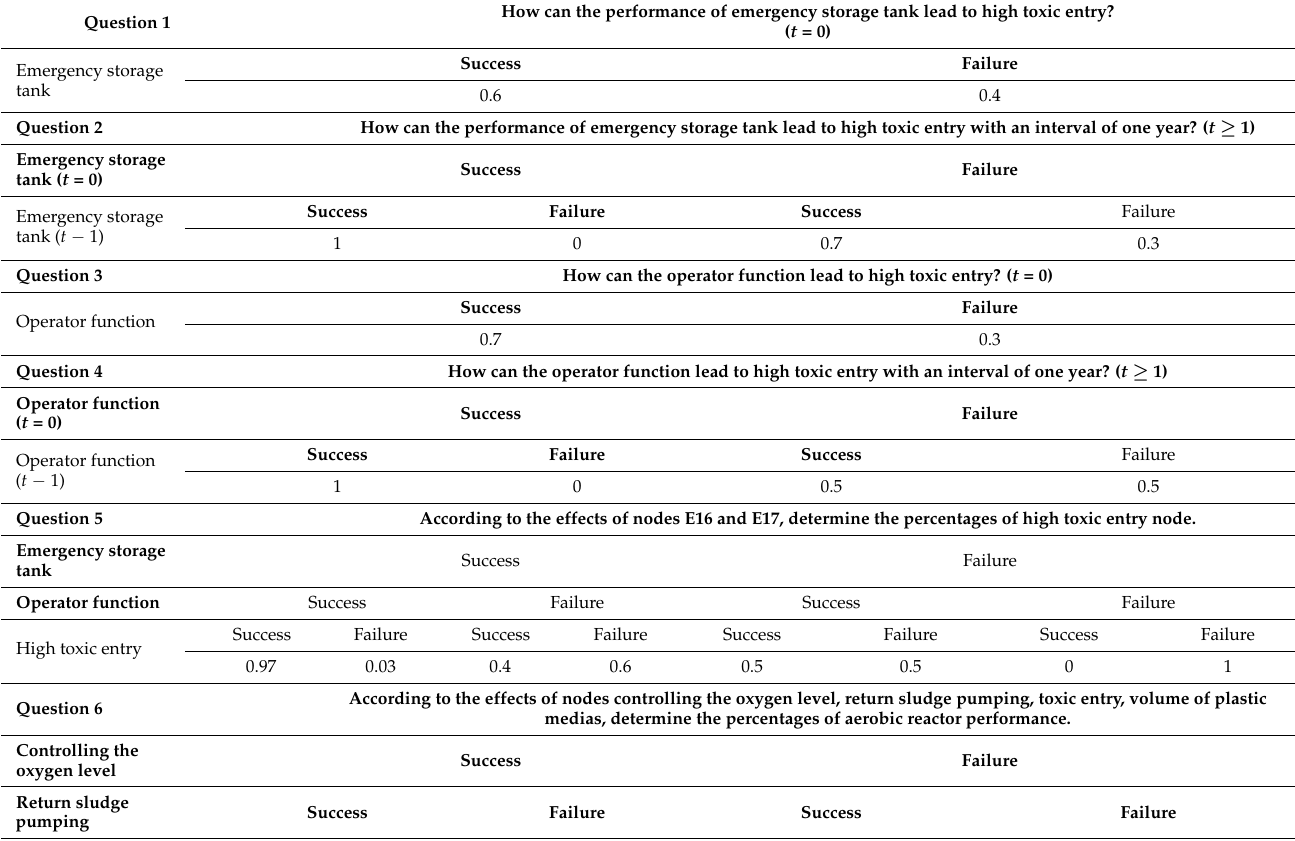
Table A1. Sample of filled-out